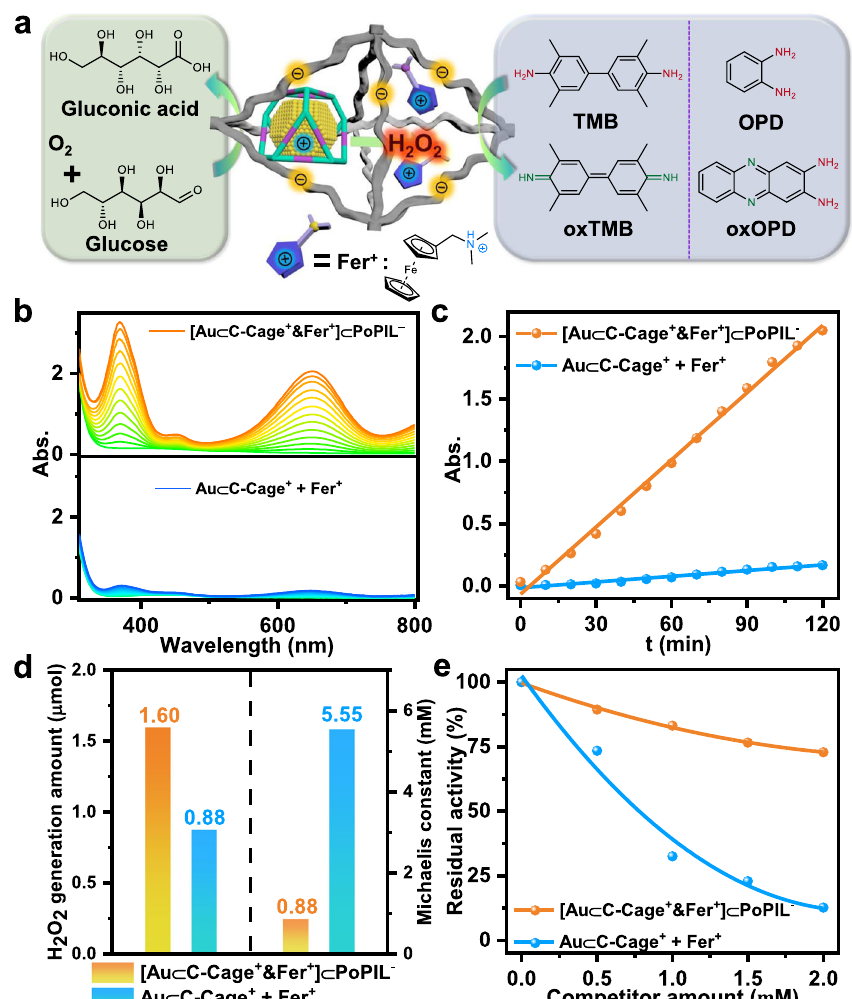
Fig. 5 Acceleration of the enzymatic-like cascade reaction by con fi ned [Au ⊂ C-Cage + &Fer + ] ⊂ PoPIL − catalyst. a Scheme illustration of the spatially separated Au ⊂ C-Cage + and a cationic ferrocene co-catalyst (Fer + ) in the [Au ⊂ C-Cage + &Fer + ] ⊂ PoPIL − network to mimic the compartmentalization in organelles, which further catalyze enzymatic-like cascade reactions by channelling the substrate to nanocon fi ned catalysts assisted by the nanochamber. The molecular structure of Fer + is displayed (counteranion is omitted for clarity). b UV-Vis spectra and ( c ) linear fi tting of the reaction rate constant for TMB oxidation cascade reaction, ( d ) H 2 O 2 production amount in the fi rst-step of glucose oxidation and K m comparison in the second-step of TMB oxidation, ( e ) relative residual activity for the TMB oxidation cascade reaction with different competing thiourea concentrations by con fi ned [Au ⊂ C-Cage + &Fer + ] ⊂ PoPIL − catalyst (orange) and a mixture of free Au ⊂ C-Cage + and Fer + catalysts (blue) in the solution. The concentrations of thiourea varied from 0 to 2mM. The above experiments were all conducted at